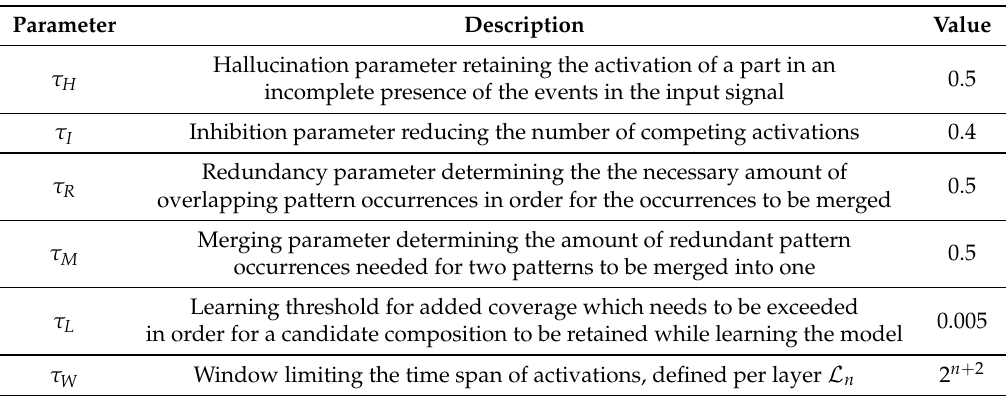
Table 1. Model’s parameter settings for the experiment. Parameter Description Value Hallucination parameter retaining the activation of a part in an τ H incomplete presence of the events in the input signal